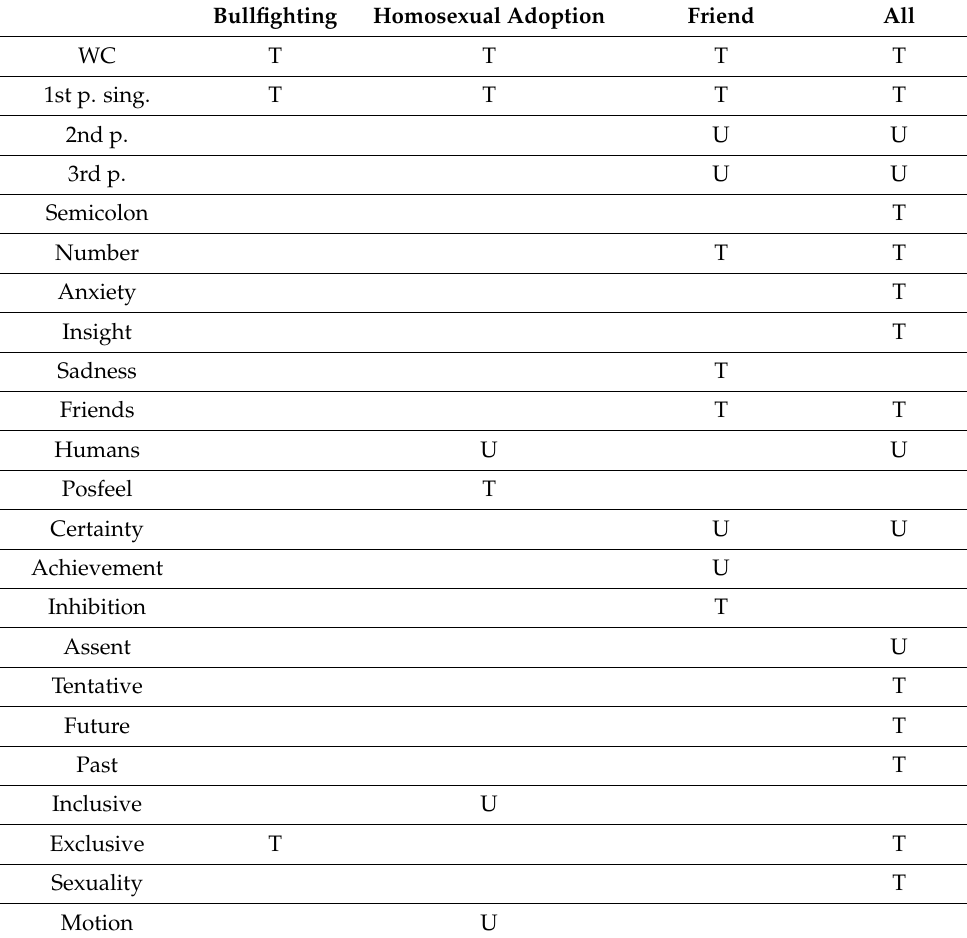
Table 3. Predictors identified for truthful and untruthful statements across the subcorpora.